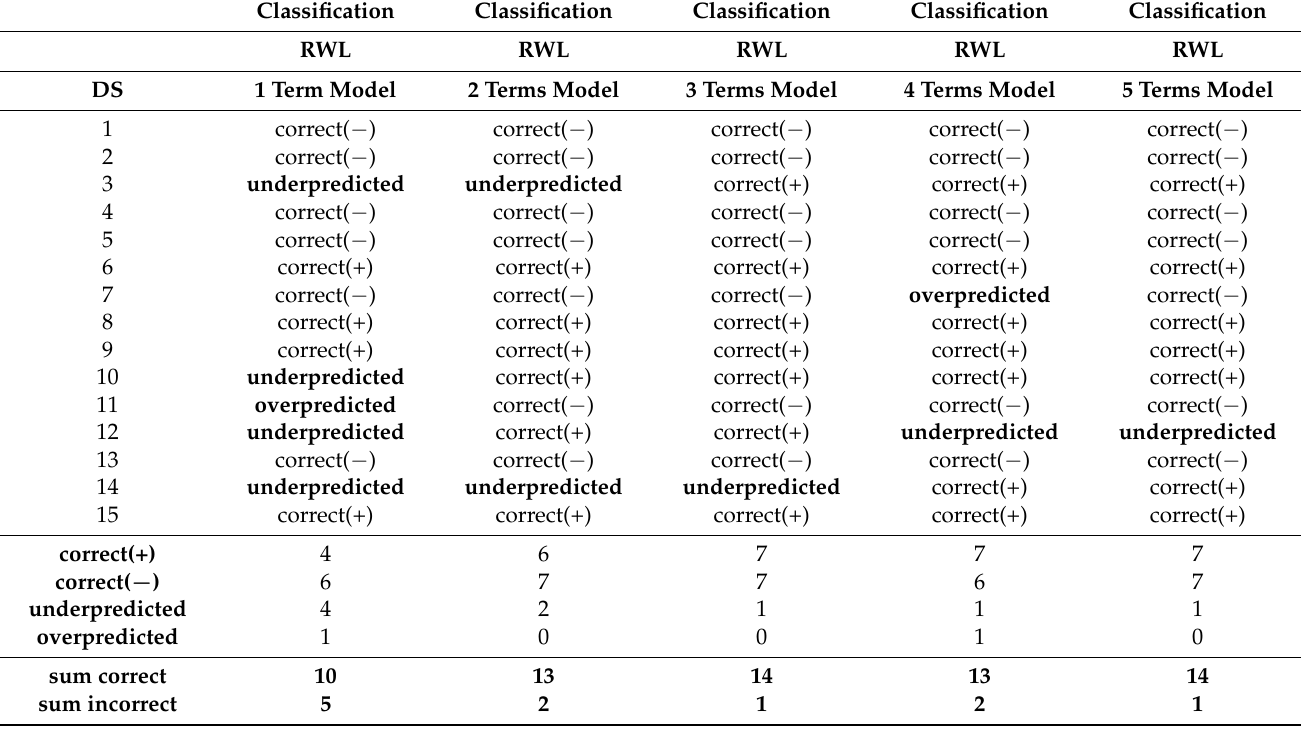
Table 6. Classification of relative weight-loss predictions for each patient under different models.